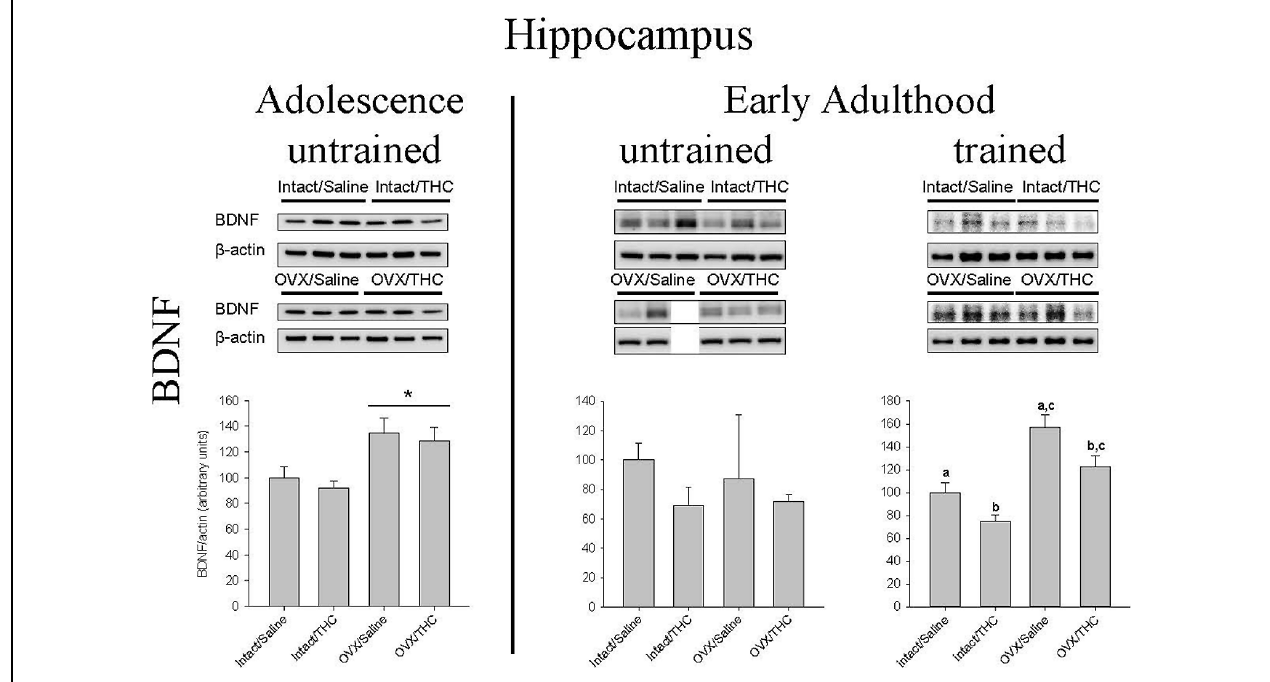
FIGURE 8 | Effects of chronic (cid:2) 9 -THC and hormone status on the endogenous levels of BDNF in the hippocampus. Above each bar graph are western blots of protein levels in hippocampal extracts from the female rats in each of the four chronically treated groups. Levels of each protein were corrected for the β -actin levels in the same samples and presented as a ratio of